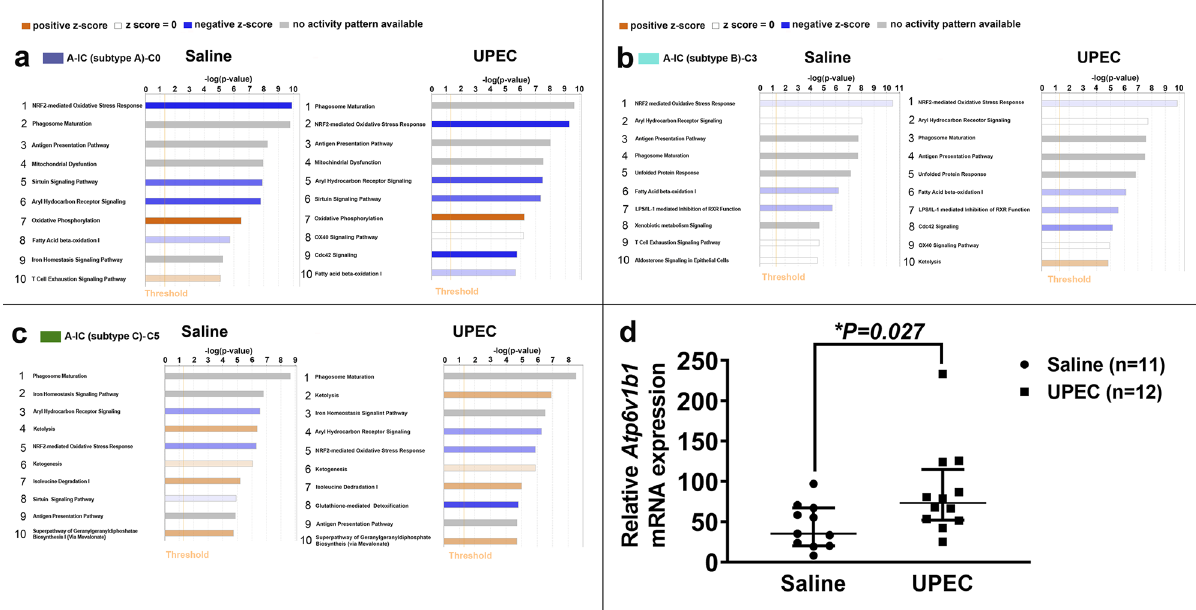
Fig. 6 Human A-ICs, but not other kidney subtypes, have differential leading biological pathways following UPEC exposure and phagosome maturation is a leading A-IC subtype biological pathway. The ten leading biological pathways ranked by p-value are presented and the colored box beside the cell type corresponds to the cluster color in Fig. 1. a With saline exposure, cluster 0/A-IC subtype A, nuclear factor, erythroid 2-like 2 (NRF2)-mediated oxidative stress response, phagosome maturation, and antigen presentation were the 3 leading biological pathways. With UPEC exposure, cluster 0/A-IC subtype A, phagosome maturation surpassed NRF-mediated oxidative stress response to become the leading pathway. TNF receptor superfamily member 4 (OX40) signaling and cell division cycle 42 (Cdc42) signaling appeared in the top ten pathways. b Cluster 3/A-IC subtype B also had differential rankings of the ten most involved pathways. Phagosome maturation moved from the fourth to third most involved pathway and Cdc42 signaling, OX40 signaling, and ketogenesis replaced xenobiotic metabolism, T-cell exhaustion signaling, and aldosterone signaling in epithelial cells as the eighth, ninth, and tenth most involved pathways with UPEC compared to saline exposure. c Cluster 5/A-IC subtype C was the remaining cell type that had differential top ten involved pathways between saline and UPEC exposure. Ketolysis moved from fourth to second, aryl hydrocarbon response went from glutathione-mediated detoxi fi cation appearing with UPEC-replacing sirtuin signaling pathway that moved off of the list. a – c Data were analyzed using IPA (QIAGEN Inc., https://www.qiagenbioinformatics.com/products/ingenuity-pathway-analysis). IPA reports a p value using a right-tailed Fisher ’ s exact test. d “ IC reporter ” mice were challenged with UPEC strain CFT073 or saline transurethrally for 1 h. ICs were fl ow-sorted and Atp6v1b1 mRNA expression was analyzed. Atp6v1b1 mRNA expression increased by a median average of ~2-fold (35.23 (20.40 – 67.17) saline vs. 73.40 (51.97 – 115.00)) (UPEC) in ICs following transurethral inoculation of UPEC strain CFT073 versus saline; n = 11 mice in saline and n = 12 mice in UPEC group. Statistical signi fi cance (asterisk) between saline and UPEC exposure was determined by the Mann – Whitney test because the data were not parametric. The results are presented as the median and interquartile range. Source data are provided as a Source Data